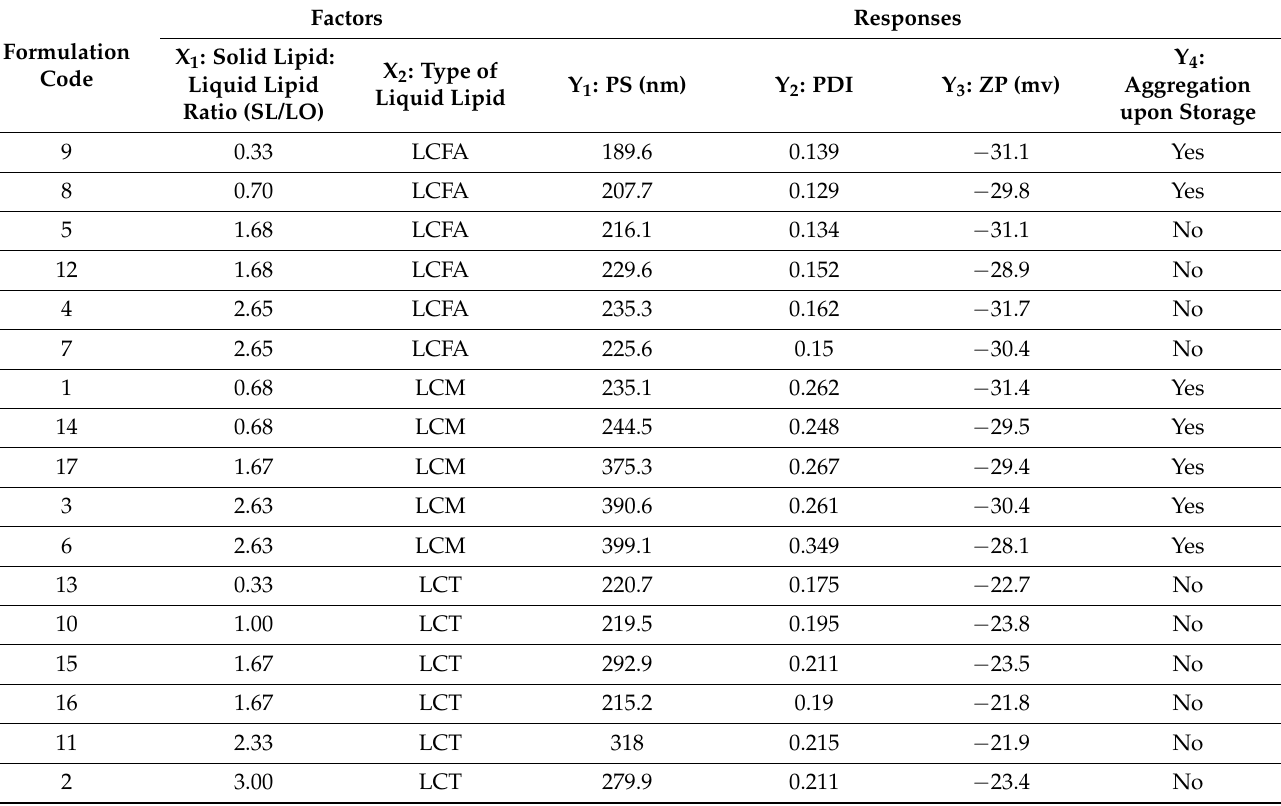
Table 1. Physicochemical properties of suggested plain NLC formulation based on the DOE model.